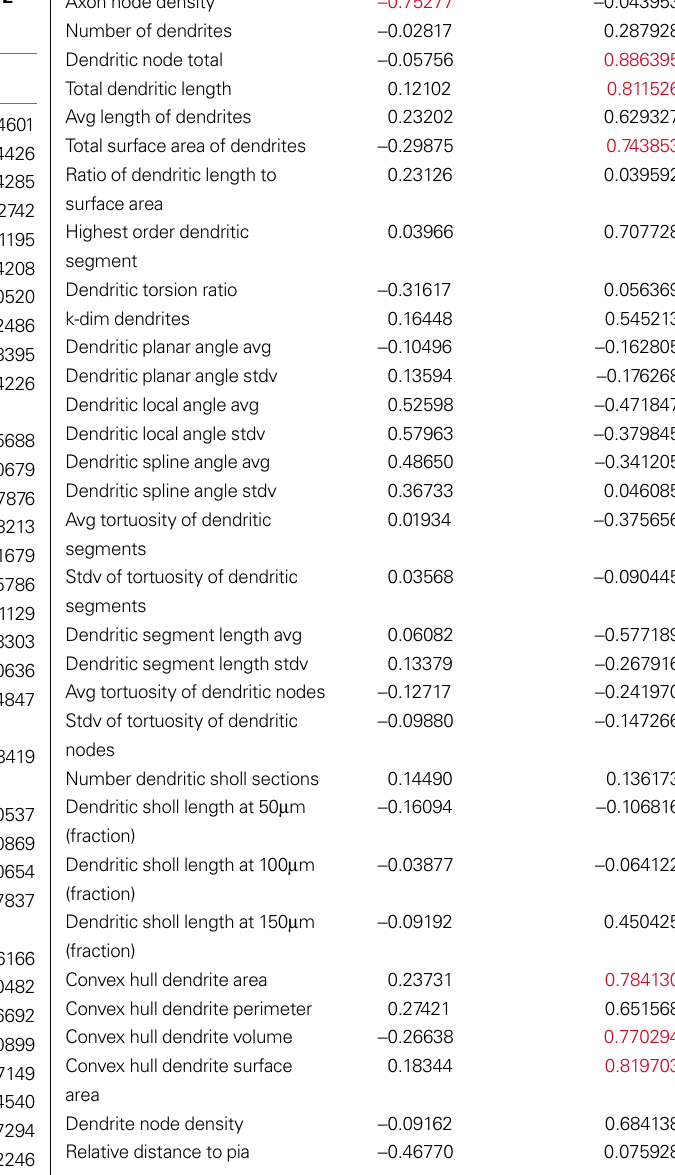
Table 6 | Correlations between morphological variables and the fi rst 2 principal components of the 39-cells morphology variables